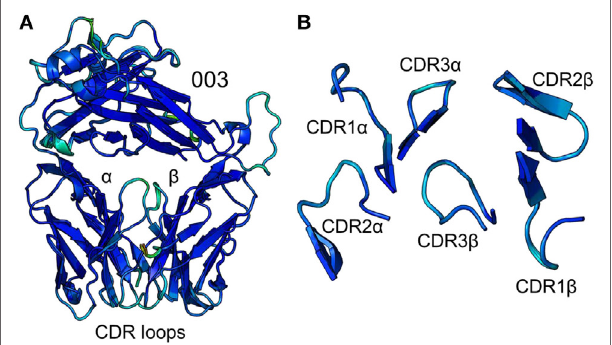
FigUre 3 | Comparison of five unbound structures of the 003 T cell receptor (TCR). (a) Side-on view of the overall conformation of the 003 TCR (cartoon, colored by B-factor) including alignment of structures generated from five different crystals. (b) Top down view of an alignment of the complementarity determining region loops (cartoon, colored by B-factor) from the five structures of unbound 003 TCR.